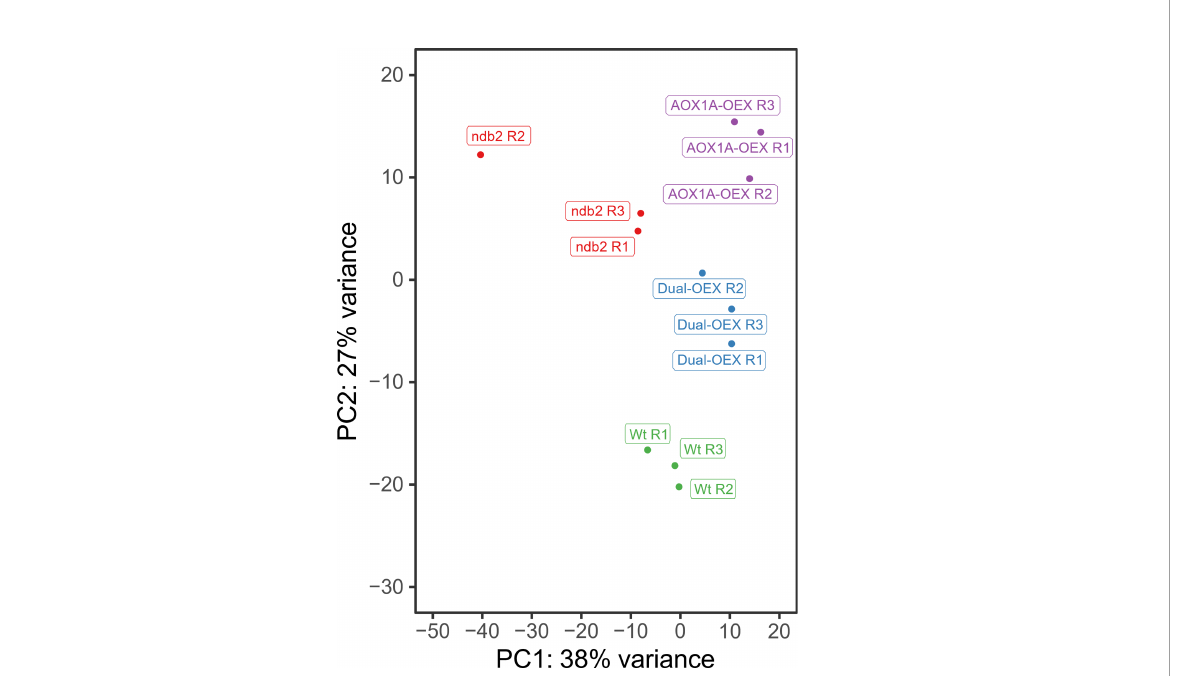
FIGURE 1 PCA plot of RNAseq data. Each point represents an individual replicate of wild type (Wt, green), AOX1A-OEX (purple), dual-OEX (blue) and ndb2 (red). The proportion of variance explained by PC1 and PC2 are indicated in the axis